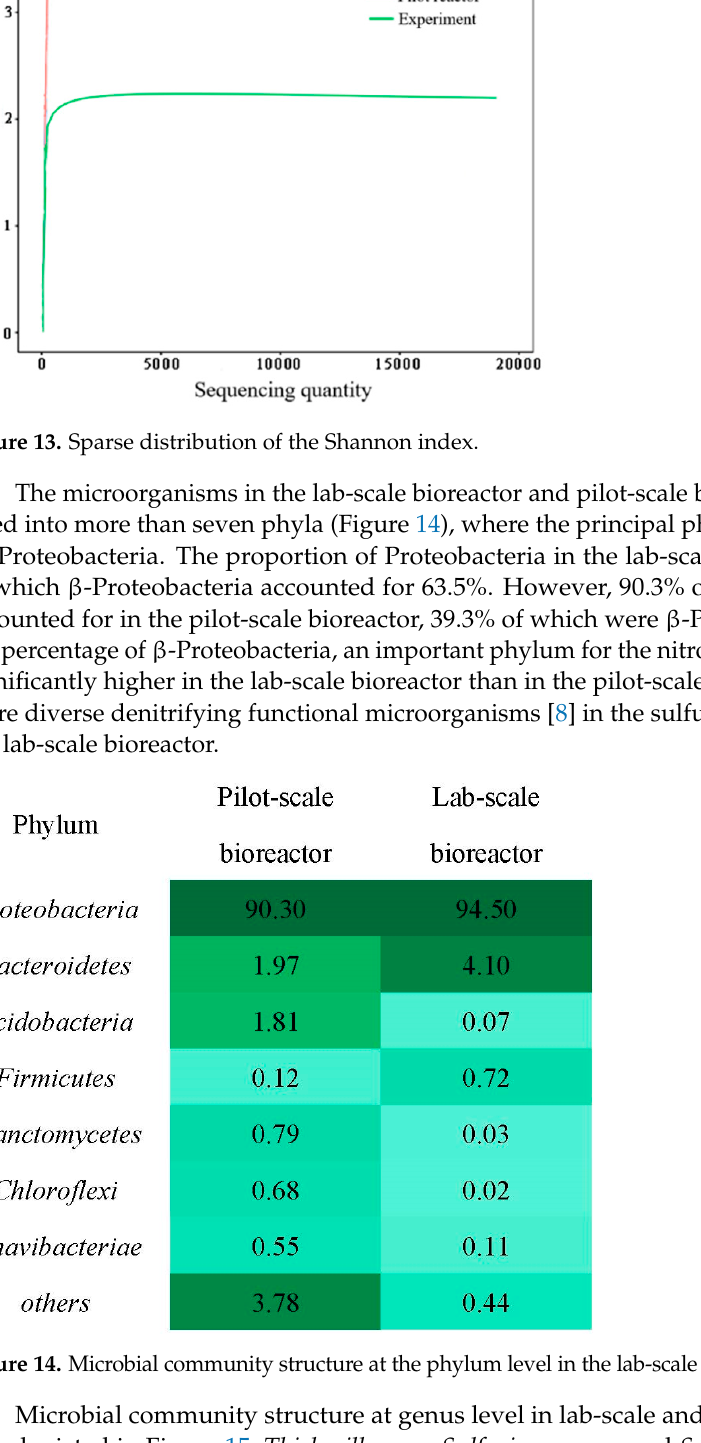
Time （ h ） Backwashing Figure 12. Backflush recovery of pilot-scale bioreactor. 3.6. Microbial Community Structure 3.6.1. Microbial Community Characteristics in the Lab-Scale and Pilot-Scale Bioreactor The Shannon index was used to analyze the diversity of microbial populations on the sulfur particles, and the indices were 2.22 and 3.92 in the lab-scale and pilot-scale bioreac- tor, respectively (Figure 13). The microbial diversity in the pilot-scale bioreactor was sig- nificantly higher than that in the lab-scale bioreactor. The possible reason could be due to